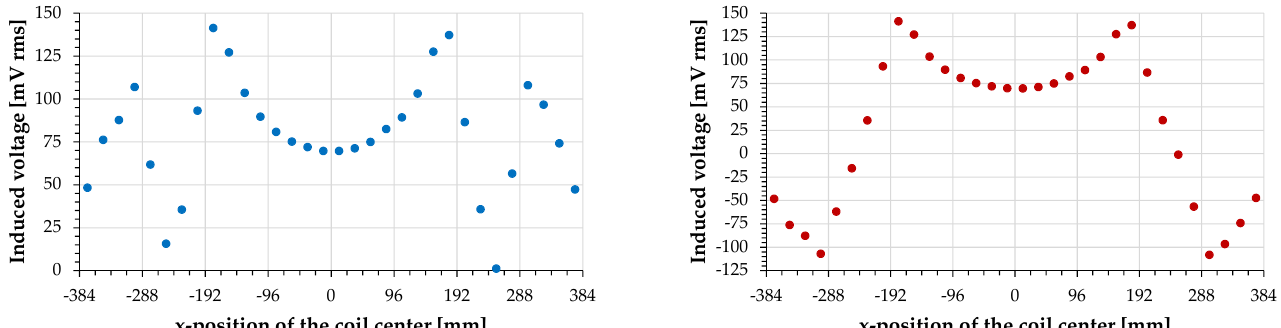
Figure 6. Voltage induced in a conductor loop of size 24mm×24mm as a function of its position ( left ) Actual measured signal amplitudes ( right ) Signal amplitudes considering the phase angle of the induced voltage.